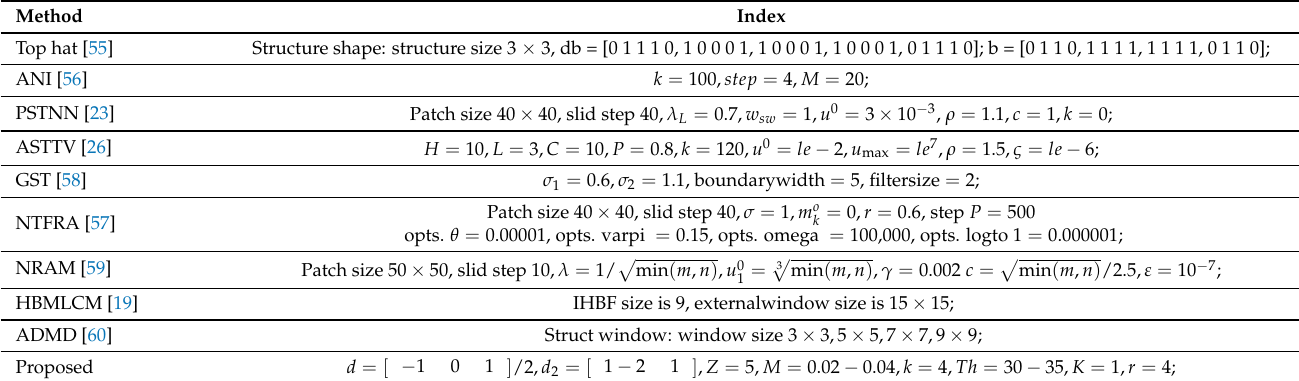
Table 4. Relevant computational parameters for each model.